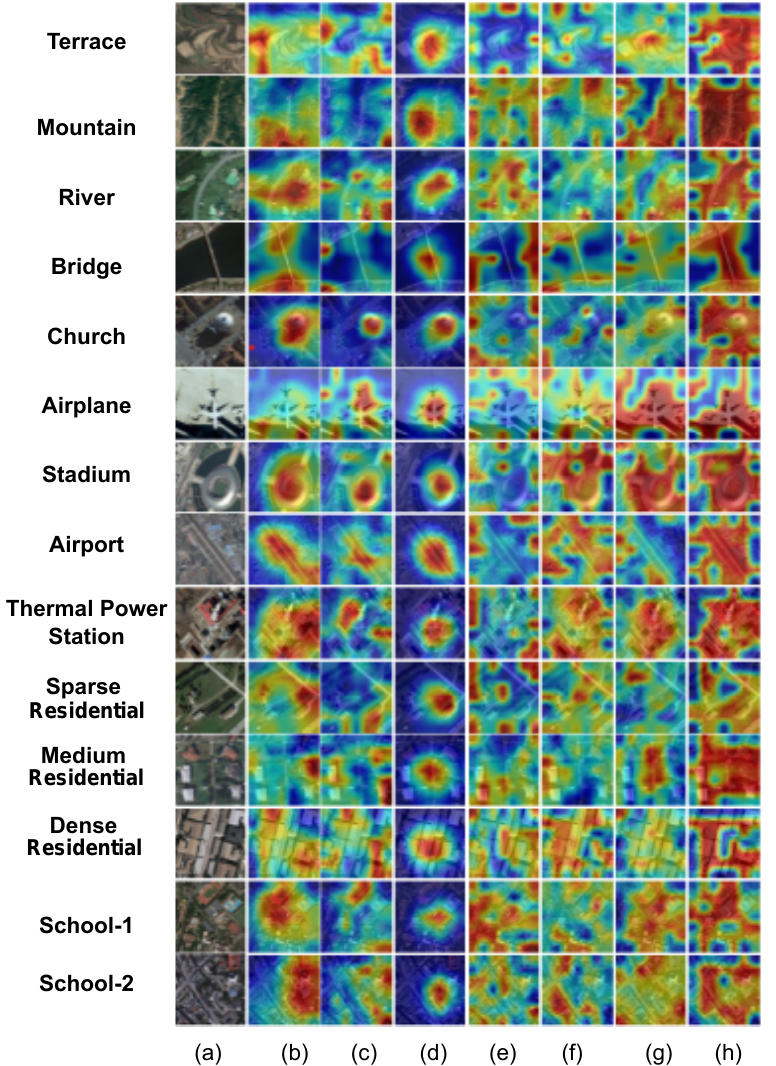
Figure 6. Comparison in terms of response maps obtained using different models on example VHR images. The original images are shown in ( a ), whereas the evaluated models are: ( b ) IMP-ResNet-50, ( c ) SeCo-ResNet-50, ( d ) RSP-ResNet-50, ( e ) IMP-Swin-T, ( f ) RSP-Swin-T, ( g ) IMP-ViTAEv2-S and ( h ) RSP-ViTAEv2-S. Here, IMP denotes ImageNet pre-training and RSP refers to remote sensing pre-training. In the response map, the warmer color indicates a higher response. Figure is from